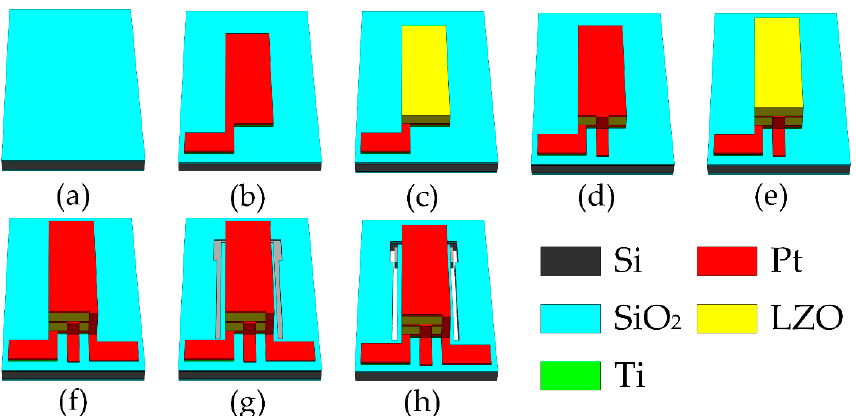
Figure 4. Main fabrication process of the chip: ( a ) Growing SiO 2 ; ( b ) depositing Ti/Pt; ( c ) sputtering Li-doped ZnO (LZO) I; ( d ) depositing Pt; ( e ) sputtering LZO II; ( f ) depositing Pt; ( g ) etching on the top side; ( h ) releasing cantilever beam.